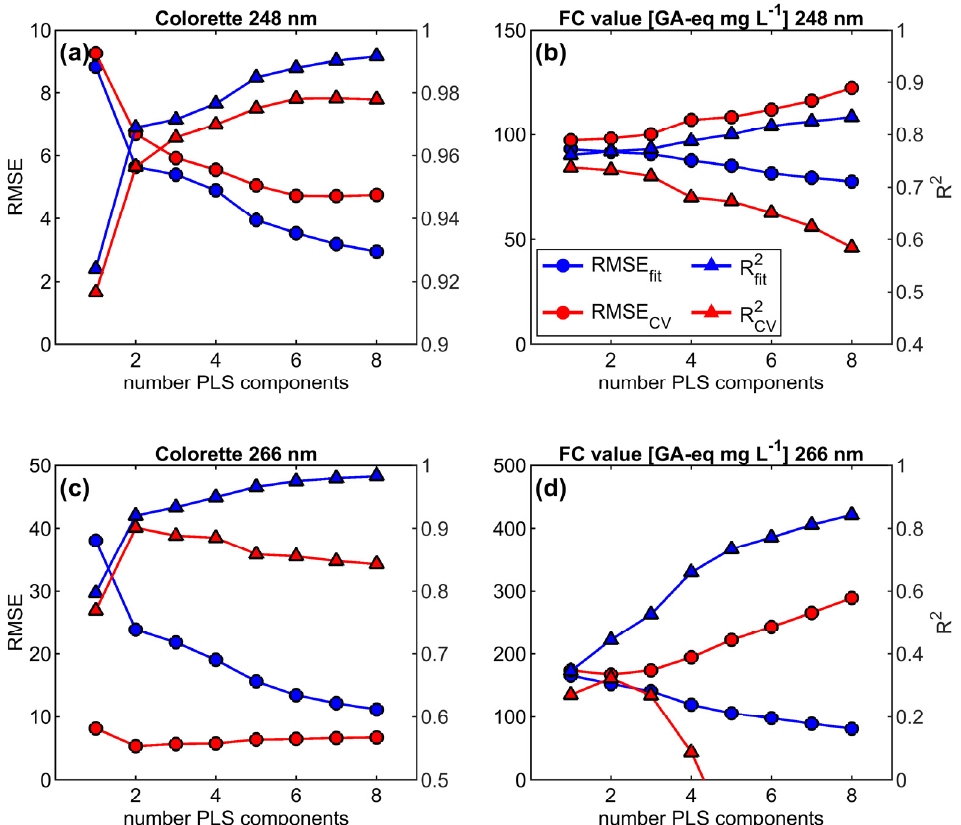
Figure 2. Results of explained variance from partial least squares (PLS) regression (R 2 fit , blue triangles), explained variance in Monte Carlo cross validation (R 2 CV , red triangles), root mean square error from PLS regression (root mean square error (RMSE) fit , blue circles) and root mean square error from Monte Carlo cross validation (RMSE CV , red circles) for the calibration data set over 8 PLS components for ( a ) Colorette values and REMPI at 248 nm, ( b ) Folin–Ciocalteu (FC) values and REMPI at 248 nm, ( c ) Colorette values and REMPI at 266 nm, and ( d ) FC values and REMPI at 266 nm. The selection of the optimal number of PLS components for modelling was based on the minimum RMSE CV and maximum R 2 CV , respectively.